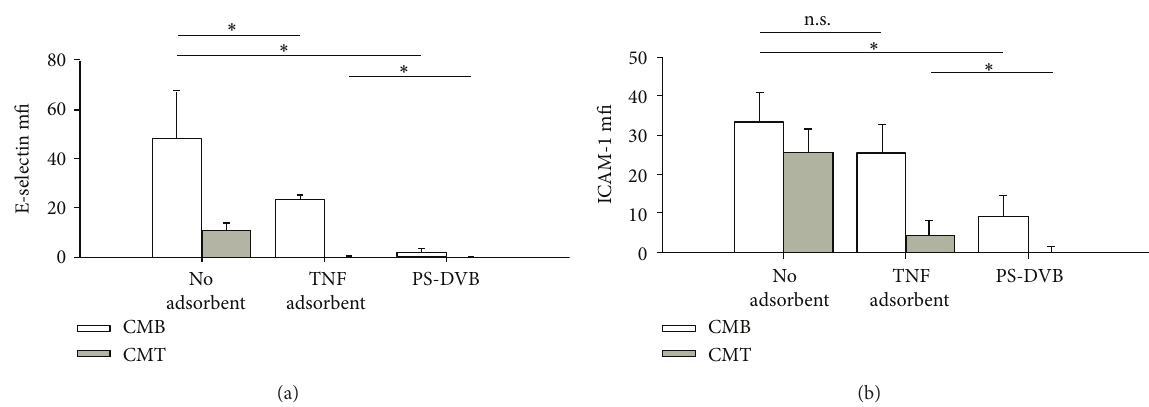
Figure 6: Effect of mediator modulation on adhesion molecule expression. The experimental setup was identical to Figure 5. HUVEC surface expression of the adhesion molecules E-selectin (a) and ICAM-1 (b) is expressed as mean fluorescent intensity (mfi) minus basal expression of adhesion molecules on HUVEC. Data are given as mean of three experiments ± standard deviation. Significance was accepted at 𝑃 ≤ 0.05 . n.s.: not